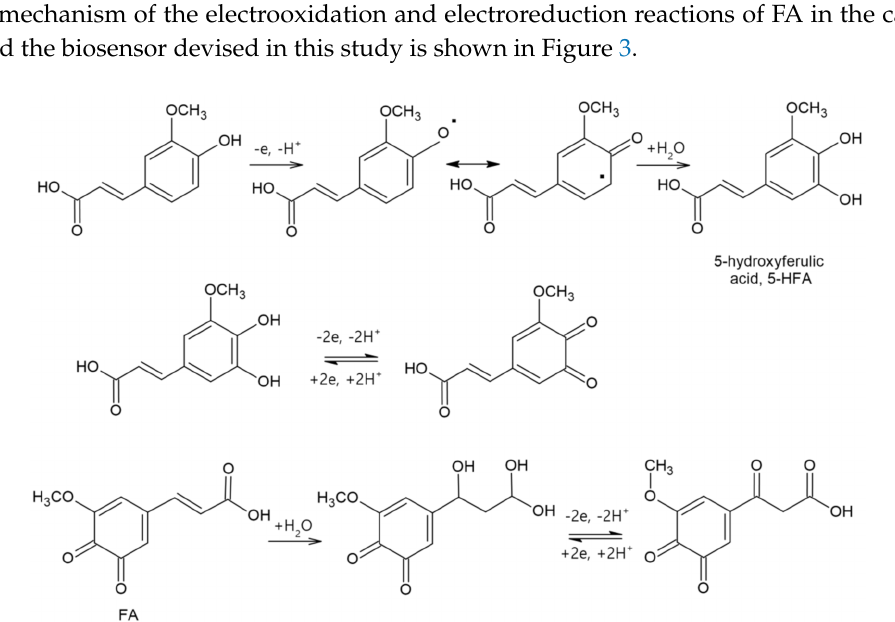
Figure 3. Proposed mechanism for the electrochemical oxidation / reduction of ferulic acid (FA)